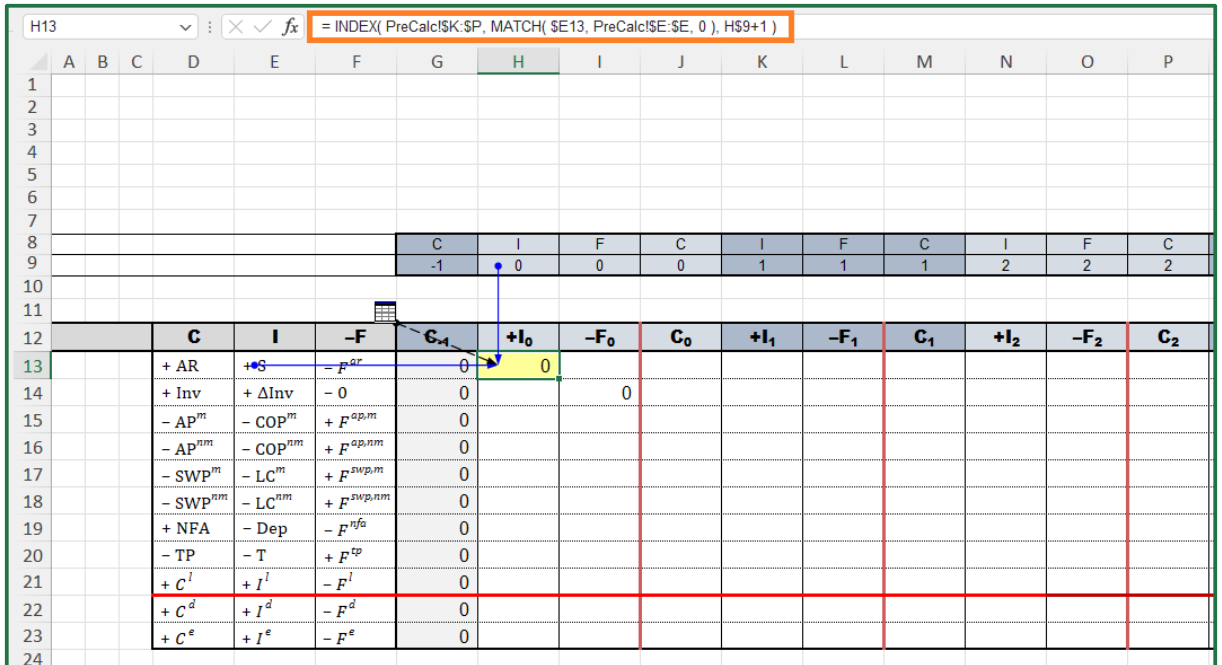
Figure 10. Cell H13 contains the formula for calculating the income component of AR (i.e., sales). Cell I14 is zero, by definition (“SplitScreenStrip” sheet).